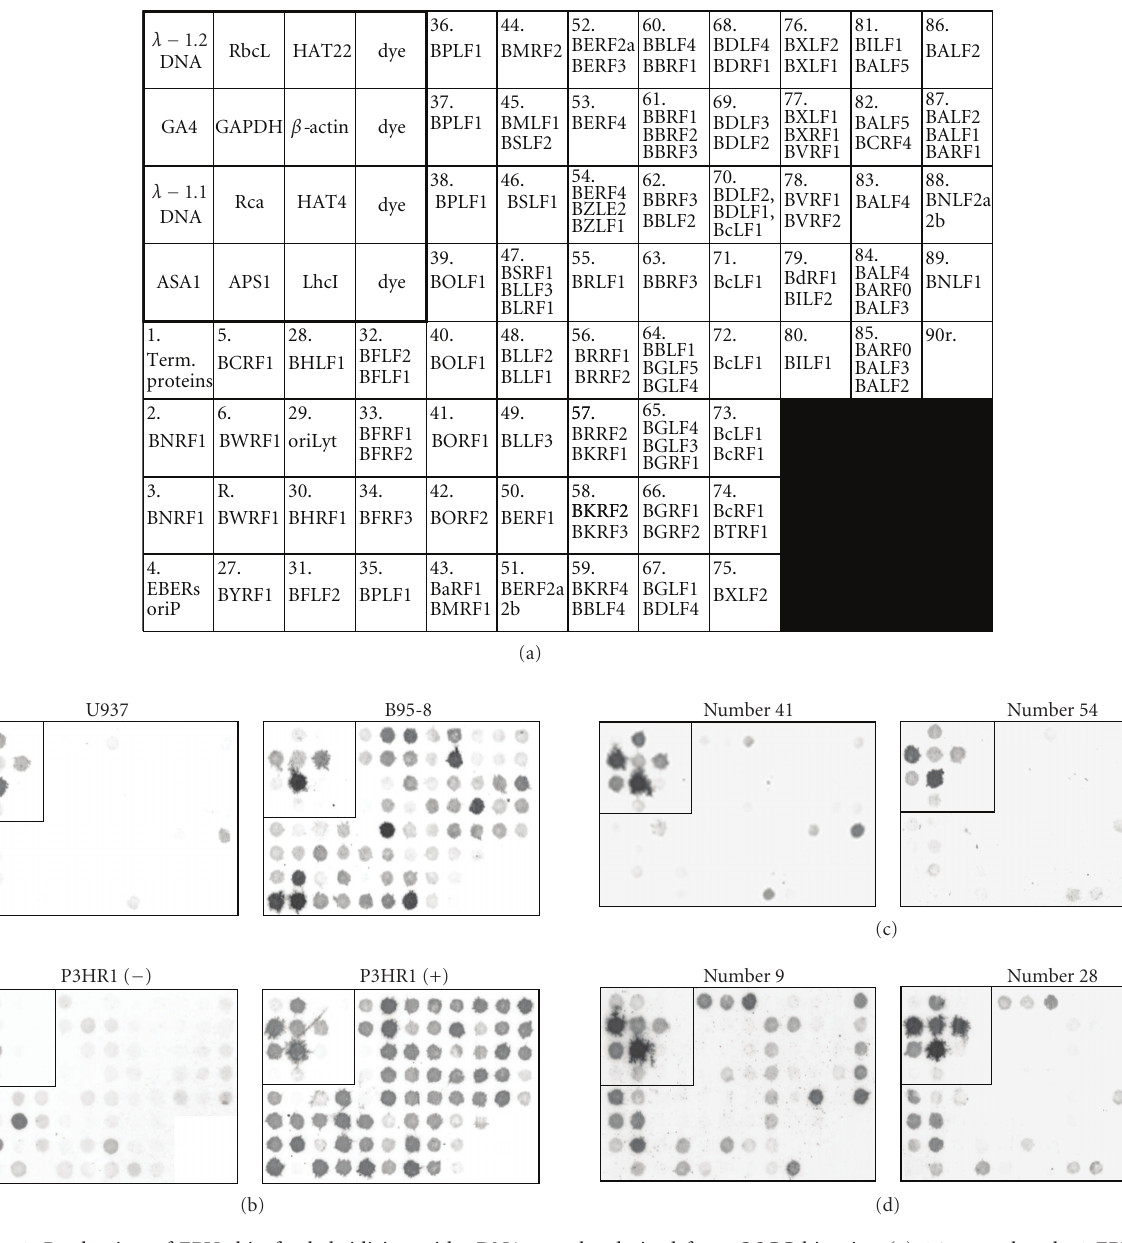
Figure 1: Production of EBV-chip for hybridizing with cDNA samples derived from OSCC biopsies. (a) 16 control and 71 EBV DNA fragments were organized into an 8-row by 12-column format with the size of 4.2 × 2.4 mm, as specified in the previous report [29]. The controls are located at the upper left corner included in the square box, where it contains 12 DNA fragments for 1.2 and 1.1 kbp Pst I- digested-lambda bacteriophage DNA, plant APS1, ASA1, GA4, HAT4, HAT22, LhcI, RbcL, and Rca genes, and human GAPDH and β -actin genes. In addition, there were four dye spots that served as the negative controls. Outside the control region, 71 EBV DNA spots, with the gene names, covering the entire EBV genome were arranged in a sequential order on EBV-chip, except that spot R was interrupted between Spots 6 and 27. Spots R and 90r contained EBV W- (internal) and terminal-repeated, respectively, sequences. The arrangement of viral DNA on EBV-chip could facilitate identification of expressed genes shown in hybridization images. (b) Total RNA samples were isolated from U937 cell line, EBV-producing B95-8 cell line, and P3HR1 cell line treated without ( − ) or with TPA and SB to induce the EBV lytic cycle (+), followed by EBV-chip hybridizations. One of each of the representative reproducible images of these hybridization experiments is shown in here, with the control regions boxed. Since U937 cells were EBV-free, no specific signal on EBV-chip spot was detected (the light color in 90r was the nonspecific hybridization signal, as discussed in the Results section). The RNA samples derived from B95-8 and P3HR1 (+) cells contained EBV transcripts, and therefore lots of, if not all, spots showed dark color, whereas a limited number of spots yielded signals when using EBV-latent P3HR1 ( − ) cDNA in hybridizations. (c) Cases numbers 41 and 54 were among those 10 EBV-negative OSCC tissues, and basically EBV-chip hybridizations of their cDNA samples revealed no expression signal. (d) Two EBV-positive tissues, numbers 9 and 28, contained substantial numbers of EBV transcripts that resulted in many dark spots in EBV-chips. The intensities of the spots were subsequently quantified and subjected to comparative analysis, as shown in Figure